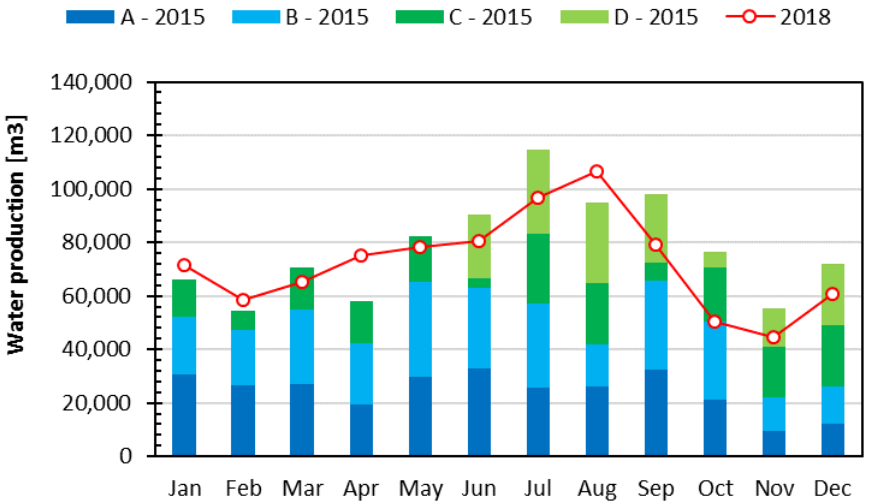
Figure 6. Freshwater production in 2018 in Pantelleria [89,90].